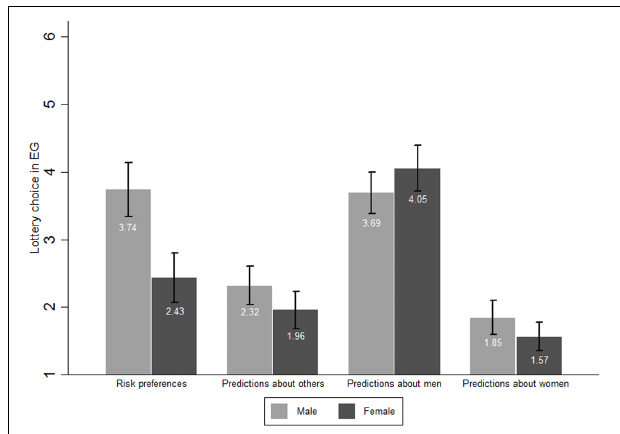
FIGURE 1 | Mean values of choices in EG Task and predictions by sex. Means of risk variables and their 95% confidence intervals grouped by sex.